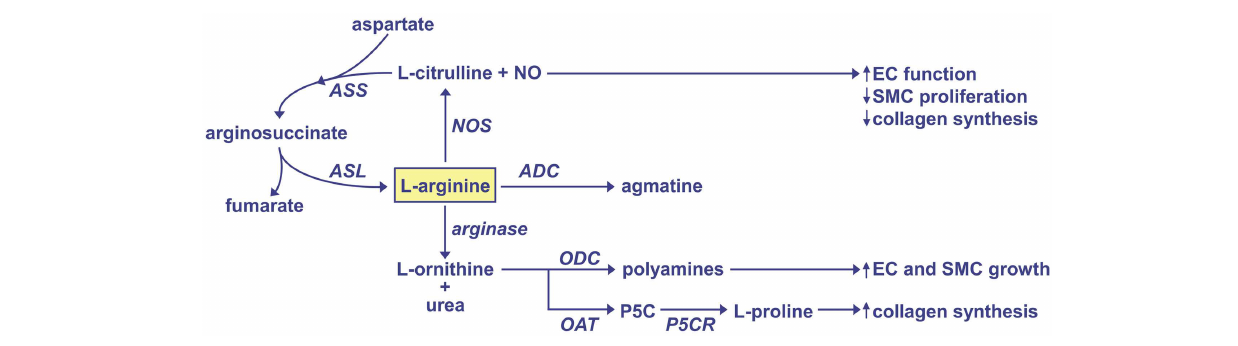
FIGURE 1 | Regulation of L-arginine metabolism by vascular cells . NO, nitric oxide; NOS, nitric oxide synthase; ASS, argininosuccinate synthetase; ASL, argininosuccinate lyase; ADC, arginine decarboxylase; ODC, ornithine decarboxylase; OAT, ornithine aminotransferase; P5C, pyrroline-5-carboxylate; P5CR, pyrroline-5-carboxylate